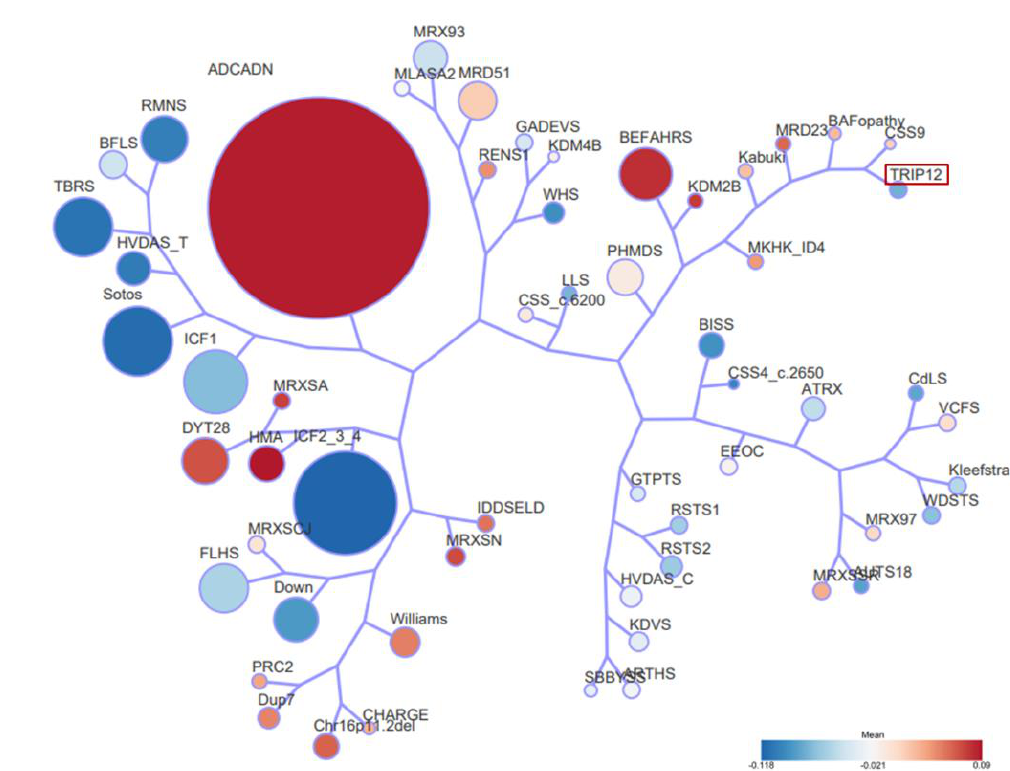
Figure 8. Relationships between the TRIP12 cohort and 56 other EpiSign™ disorders: ( a ) Methylation differences of all differentially methylated probes (DMPs) for each cohort, sorted by mean methylation. Each circle represents one probe. Red lines indicate mean methylation; ( b ) Tree and leaf visualization of Euclidean clustering of all 57 cohorts using the top n DMPs for each group, where n = min (# of DMPs, 500). Cohort samples were aggregated using the median value of each probe within a group. A leaf node represents a cohort, with node sizes illustrating relative scales of the number of selected DMPs for the corresponding cohort, and node colors are indicative of the global mean methylation difference. Abbreviations are listed in Supplementary Table S3.